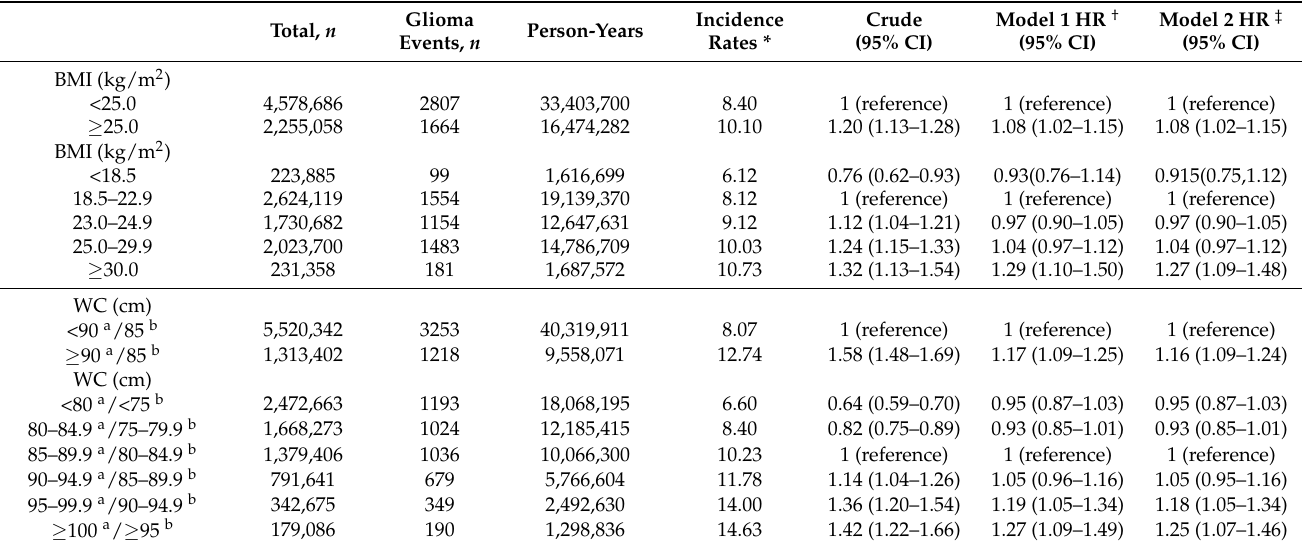
Table 2. Incidence rates and risk of glioma development according to BMI and